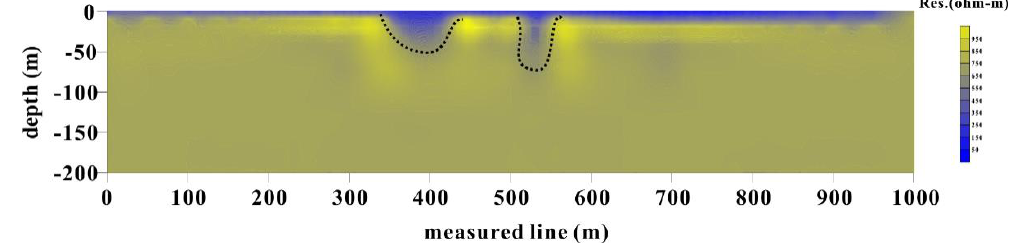
Figure 6. Inversion result of airborne transient electromagnetic response.